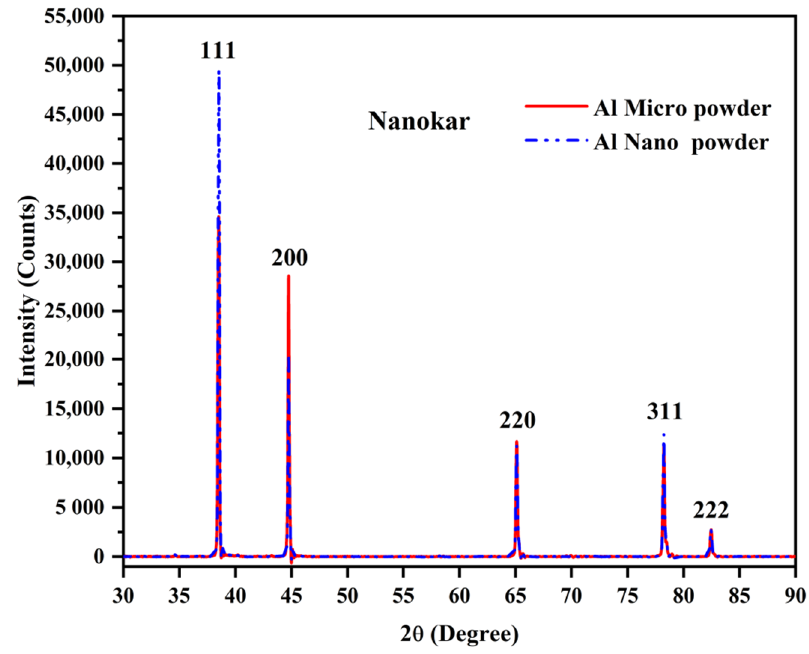
Figure 2. X-ray diffractograms of the Aluminum powders. Figure 2. X-ray di ff ractograms of the Aluminum